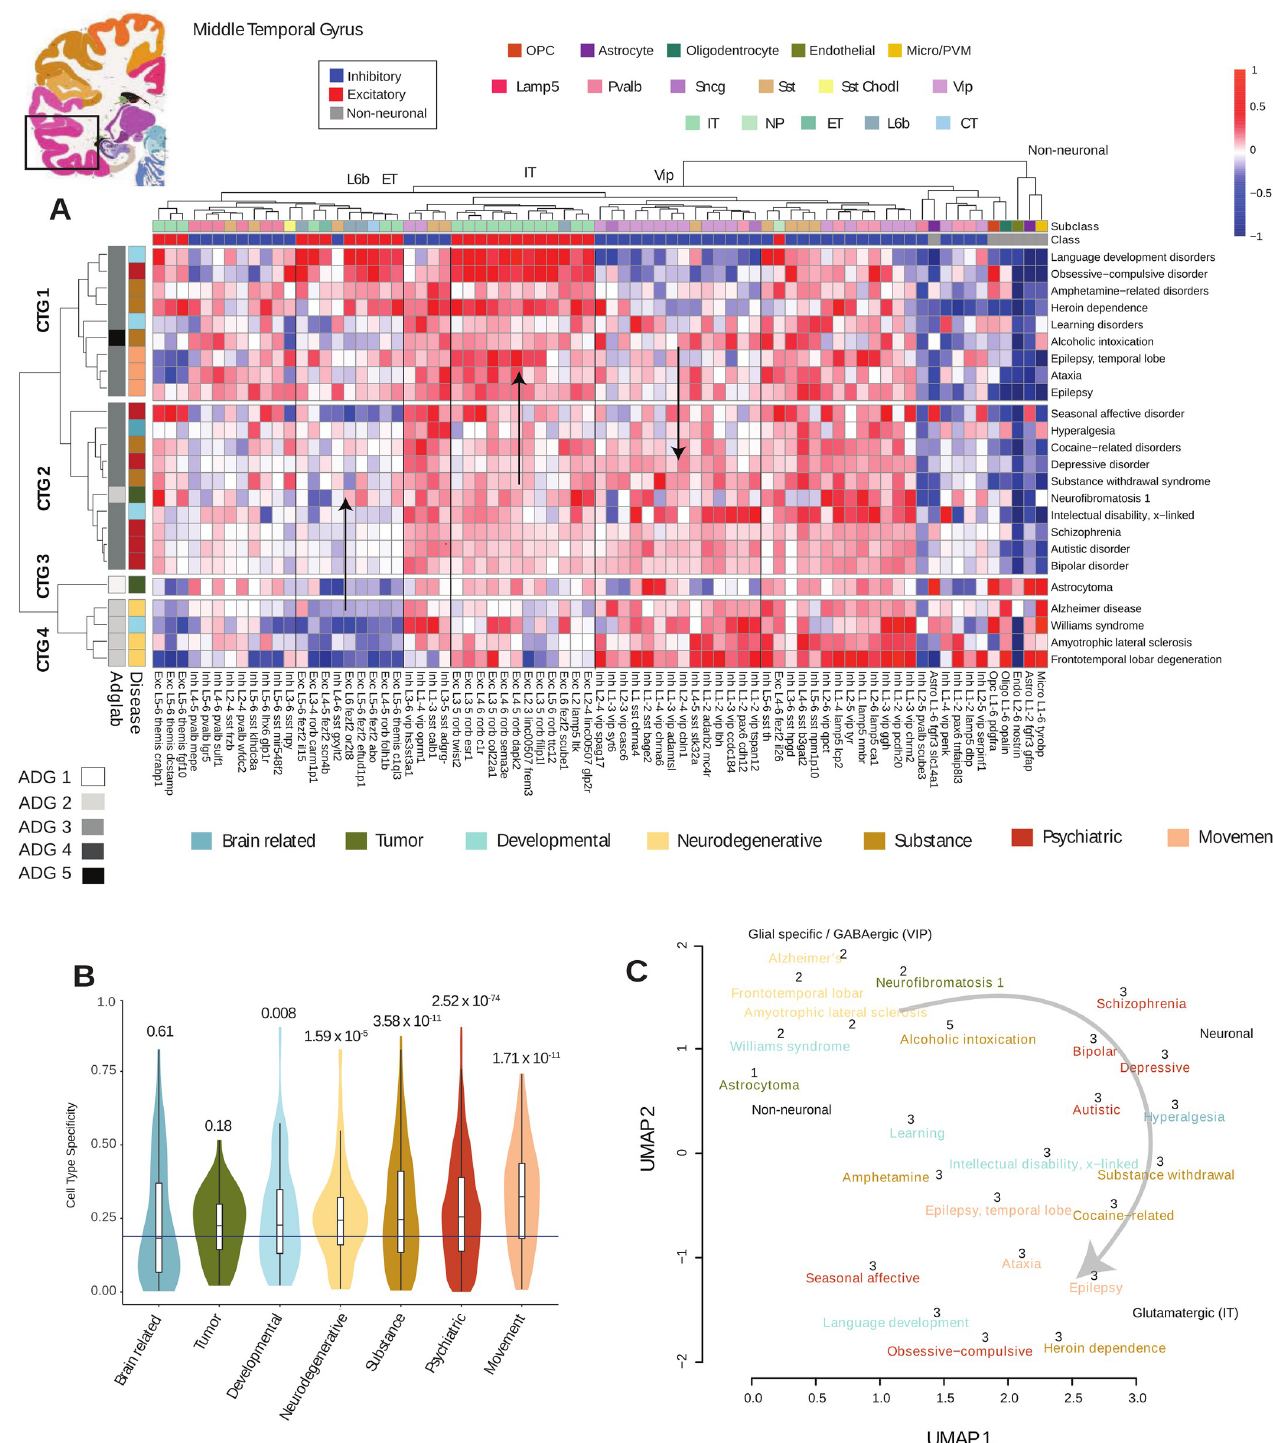
Fig 3. Disease genes and cell types of middle temporal gyrus. Coronal reference plate from the AHBA (http://human.brain-map.org) containing MTG region. (A) Mean cell type expression (CPM) of 24 cortex-related brain diseases ( Methods ) of 15,928 MTG nuclei over 75 cell types identified in [15]. Diseases and cell types are clustered and identify 4 cell type groups CTG 1–4 based on cell type expression enrichment. Left annotation: ADG group membership determined by Fig 1 , and GBD phenotypic classification. Top annotation: Major cell type classes (excitatory, inhibitory, non-neuronal) and subclass